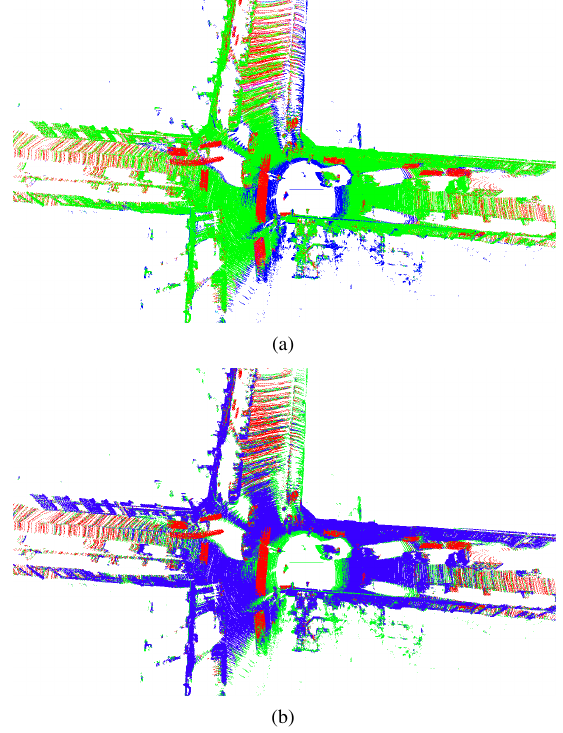
Figure 7. Moving object detection from a static laser scanner. (a)